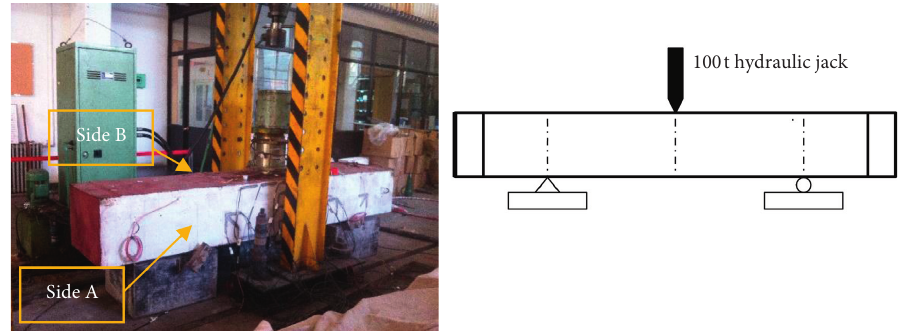
Figure 2: Loading equipment for specimens.